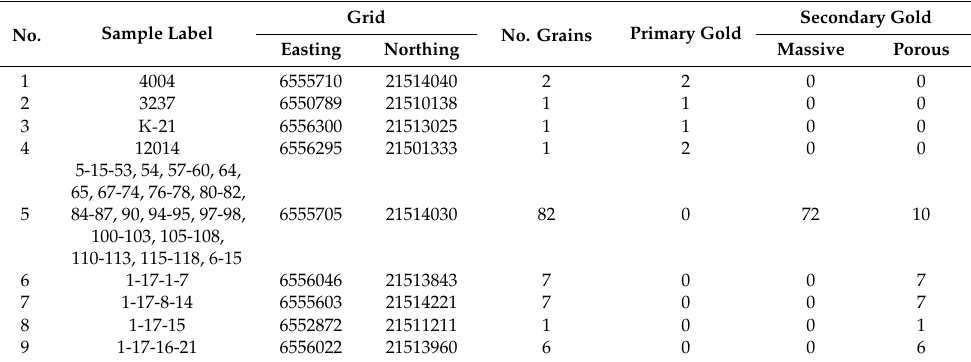
Table 1. Details of samples